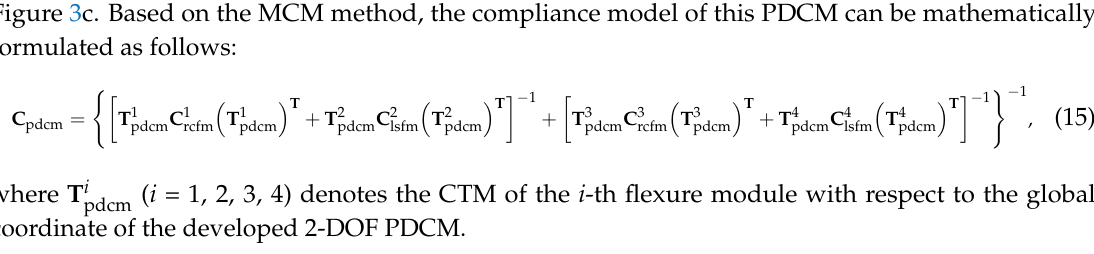
Figure 3c. Based on the MCM method, the compliance model of this PDCM can be mathematically formulated as follows: